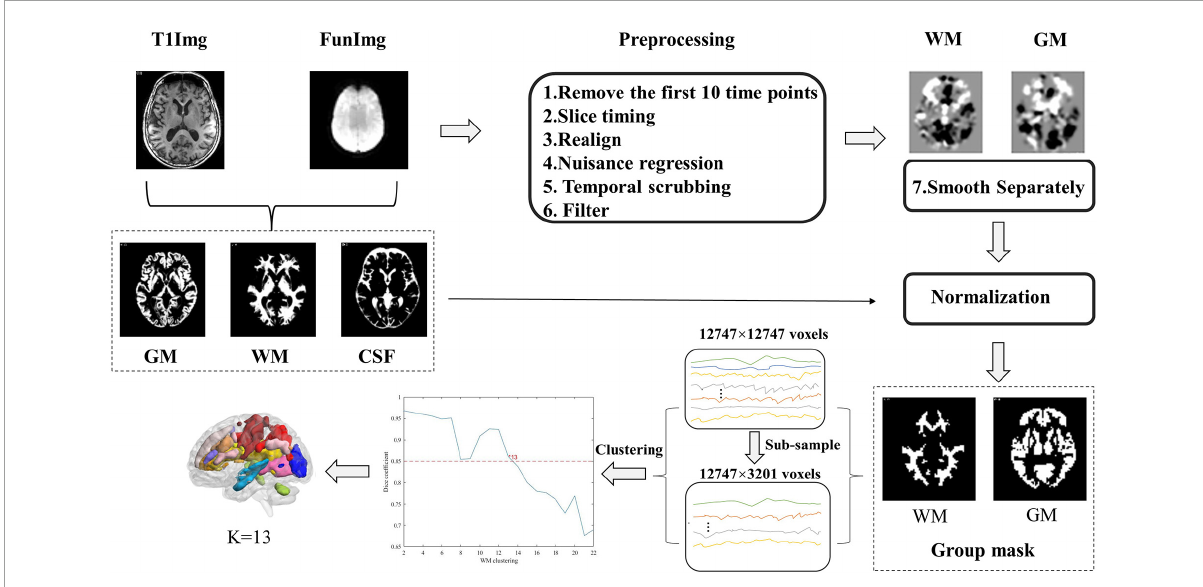
FIGURE1 Flow chart of the processing of the resting-state functional magnetic resonance imaging (Rs-Fmri) data and the clustering of